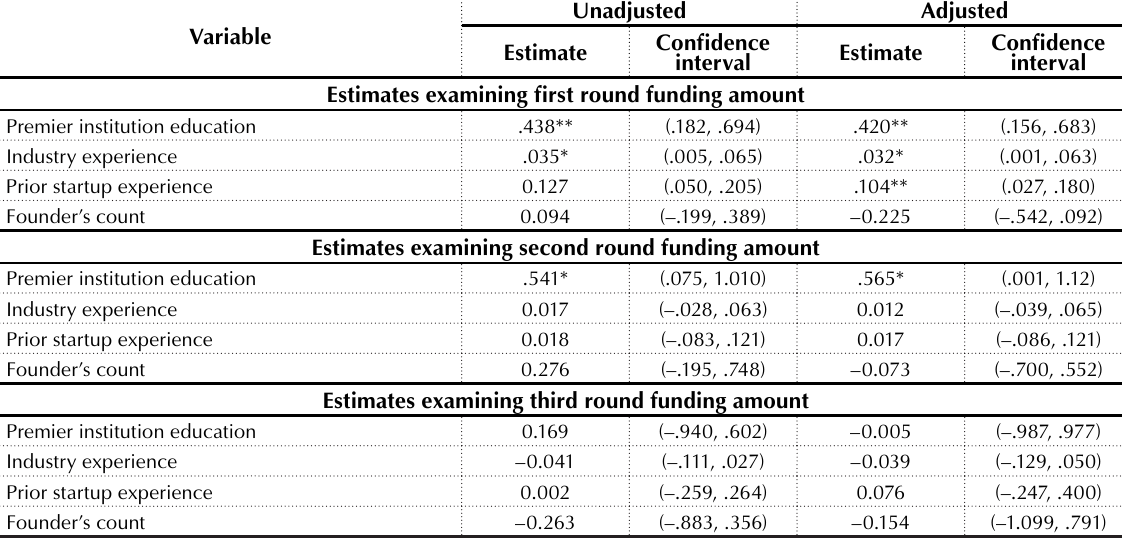
Table 7. Estimates for amount of funds raised across multiple rounds of funding using linear